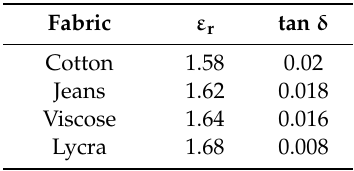
Figure 1. Microscope images for textiles substrates: ( a ) Cotton; ( b ) Jeans; ( c ) Viscose and ( d ) Lycra.